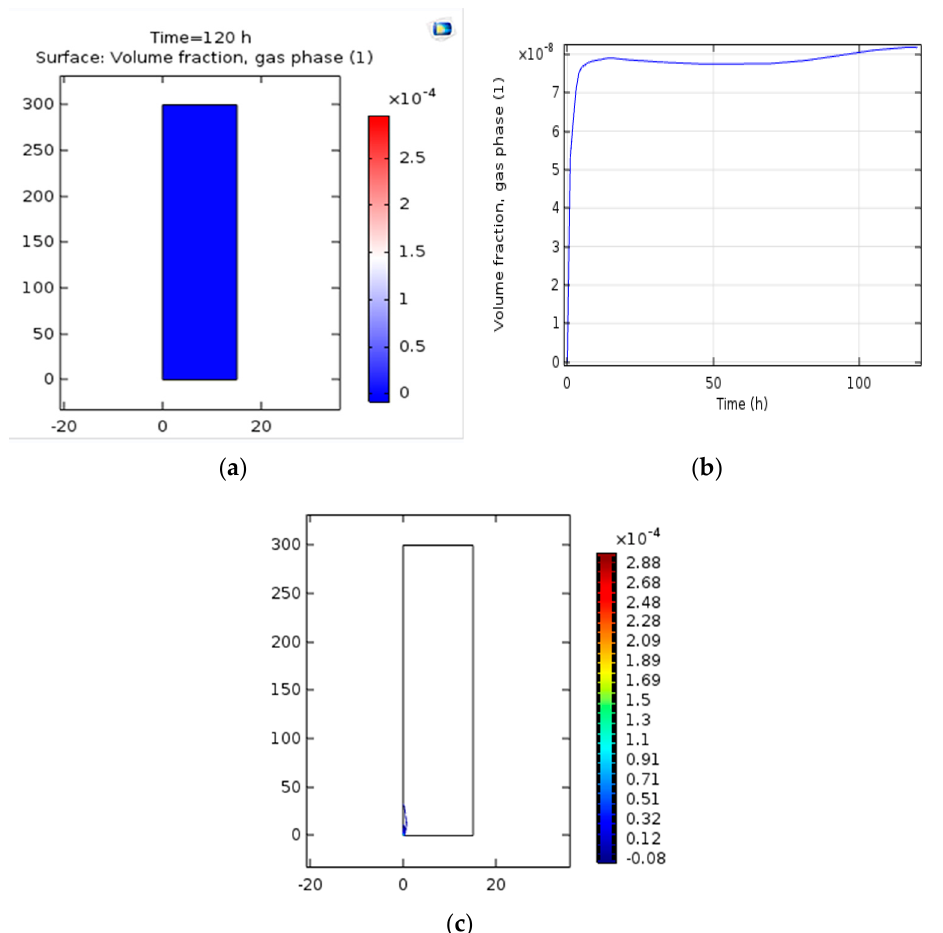
Figure 11. ( a ) The surface rate of gas accumulation along the reactor. ( b ) The rate of gas accumulation along the reactor. ( c ) Gas volume coefficient versus time.